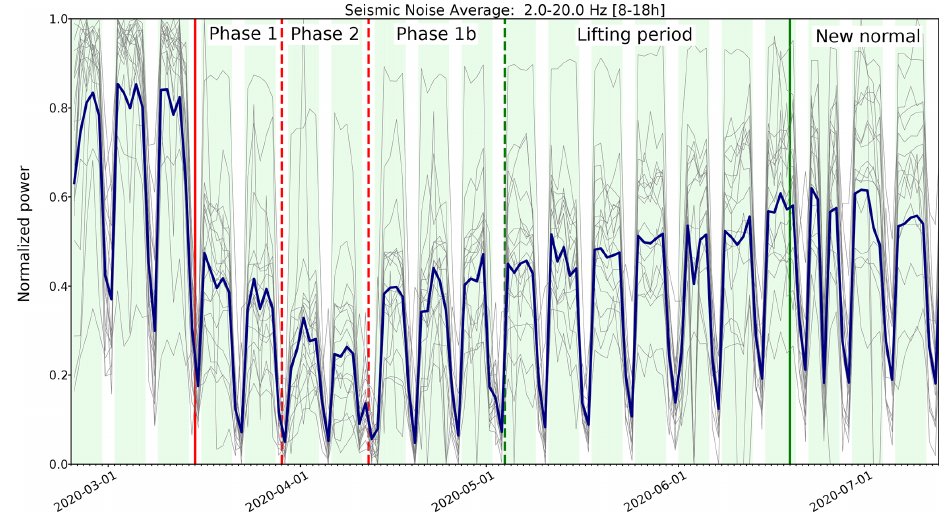
Figure 5. Normalized power in the 2–20Hz band during working hours for all the stations (gray lines) and the corresponding mean profile (blue line). Bars as in Fig.